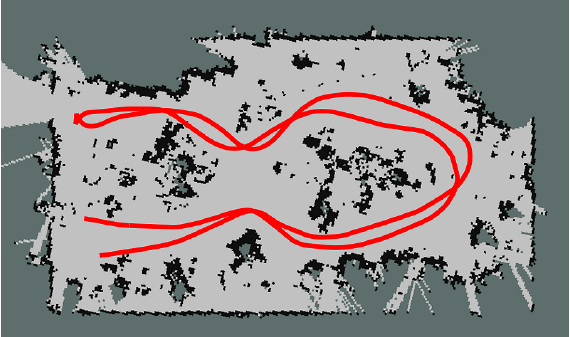
Figure 12. Map of the greenhouse used in the experiments. In light gray, the free spaces; in black, obstacles; in dark gray, unknown spaces; and in red, the robot path.